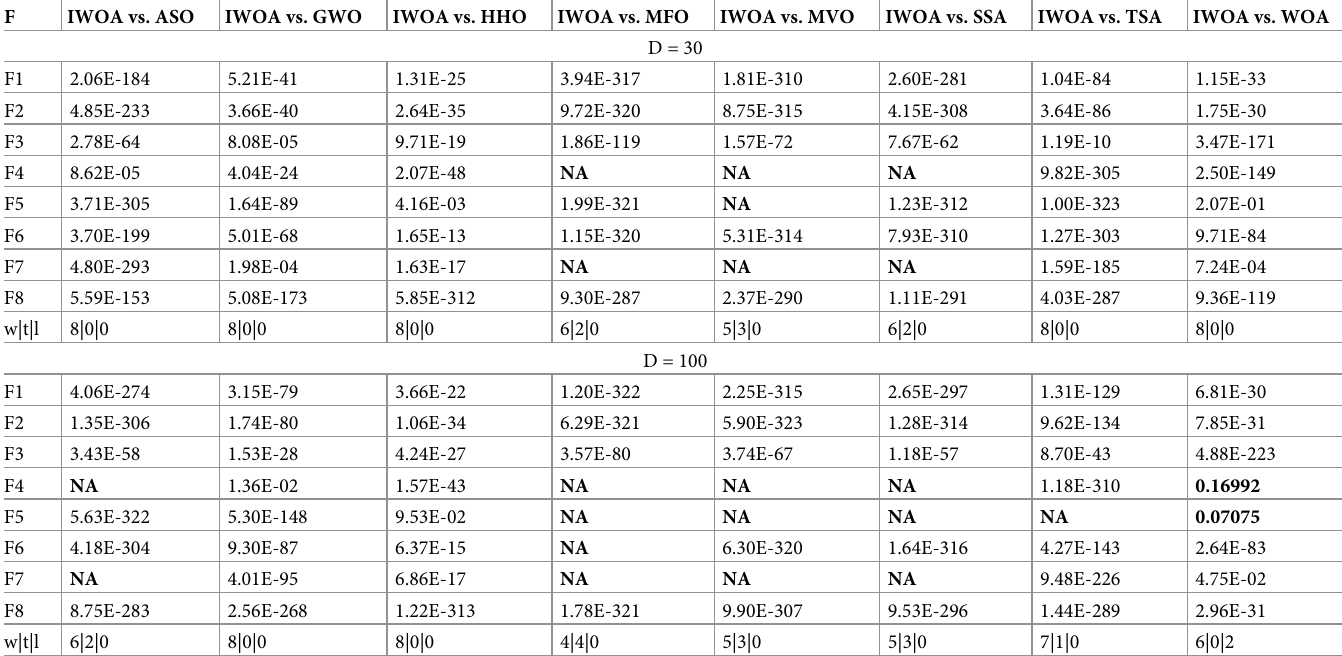
Table 5. p -value of the Wilcoxon test for the optimization results of IWOA and other algorithms based 8 benchmark functions (p > = 0.5 are in bold). F IWOA vs. ASO IWOA vs.